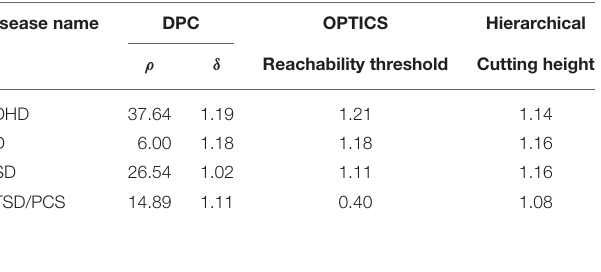
TABLE 7 | Peak similarity (highlighted), corresponding number of features, and number of clusters obtained using SFR, SFS, and GA with different clustering methods for ADHD dataset. Feature selection Clustering method